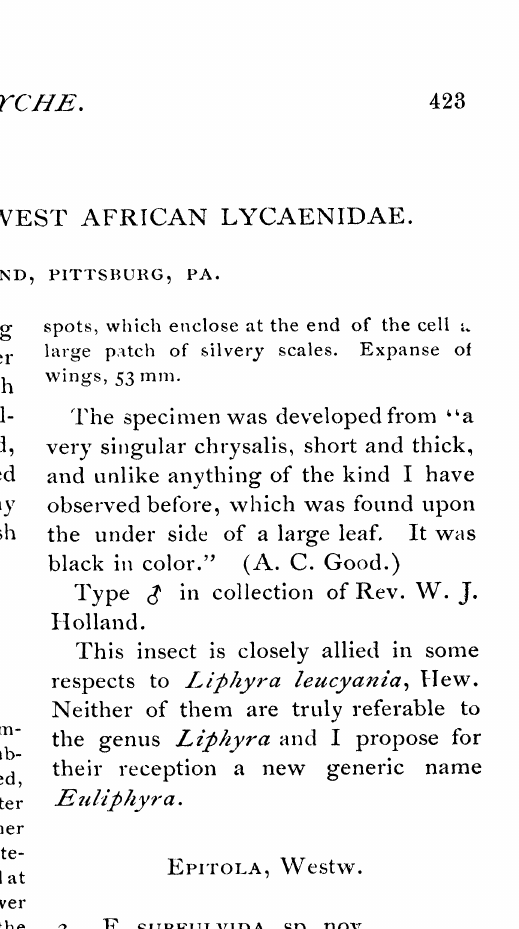
gin and the upper part of the cell midway between the base and the apex. The white spot of the upper surface reappears upon the under side. The secondaries are lavender gray shading toward the outer margin into pale fuscous and ornamented by a number